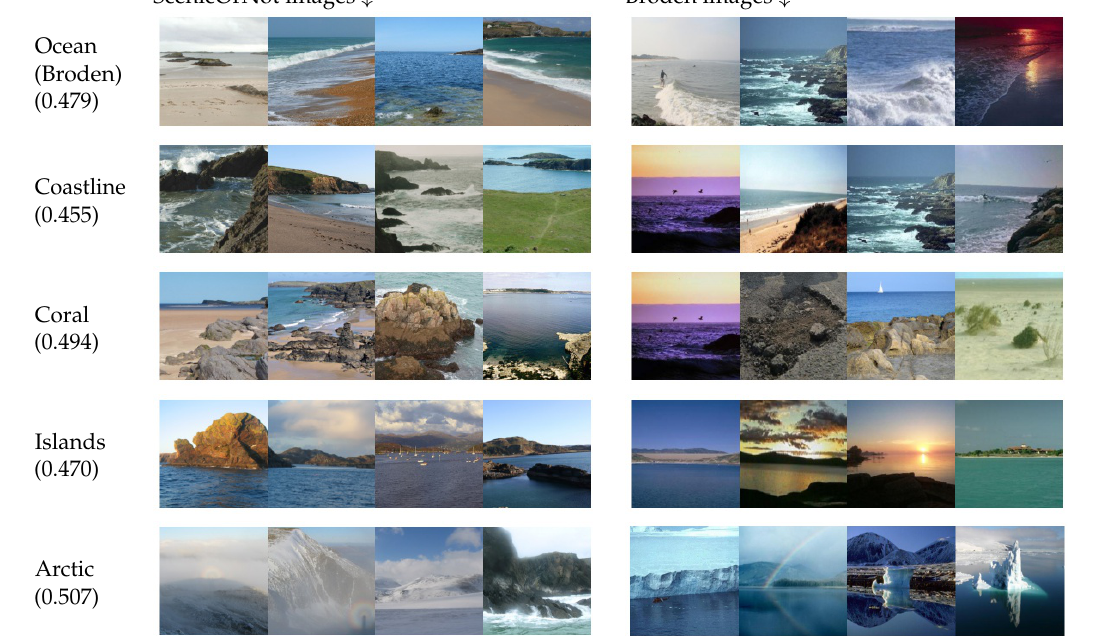
Figure 11. Closest images for ocean, a concept that has been trained with visual examples from Broden (top row) and its corresponding neighboring concepts from GloVe. Each concept shows its correlation with scenicness in the latent